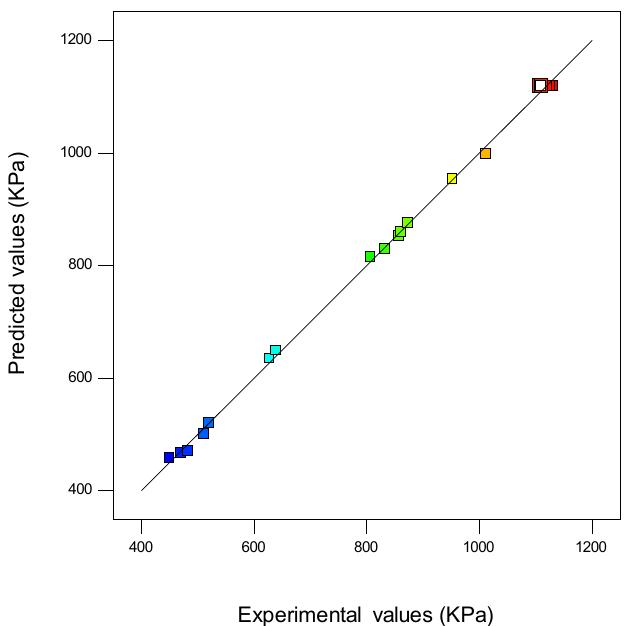
Figure 1. The relationship of calculated values and experimental values.